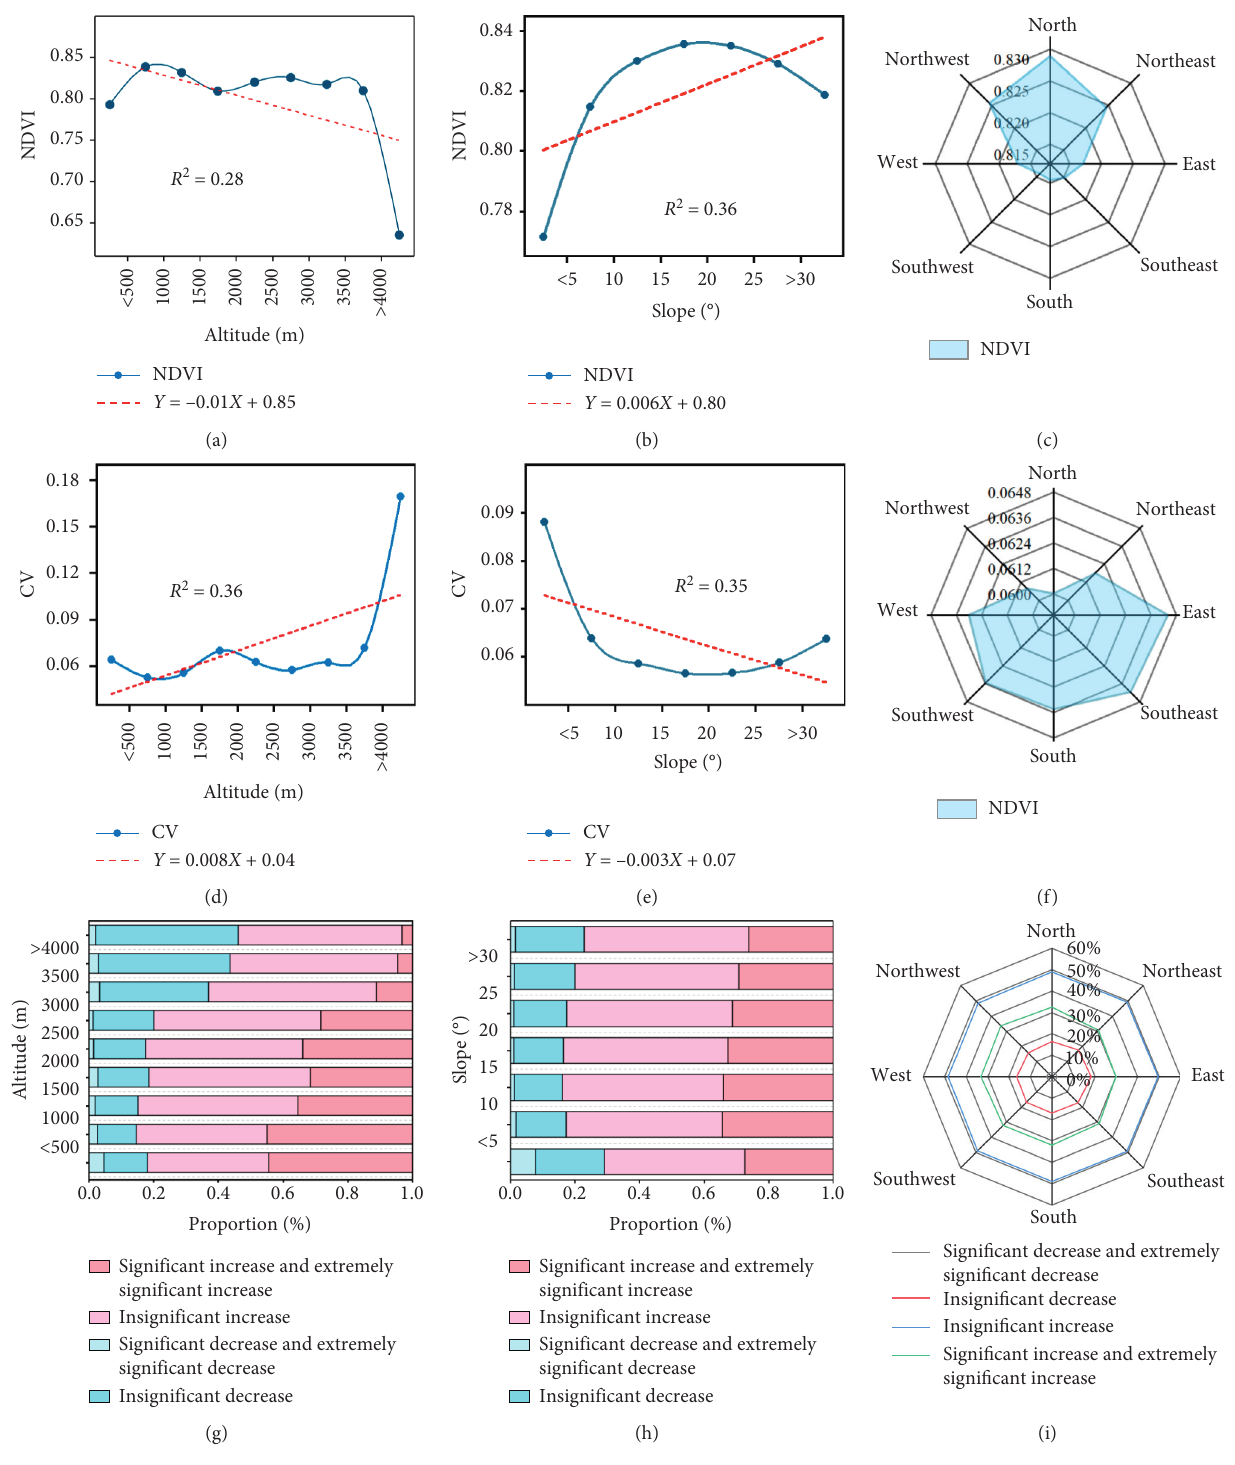
Figure 4: The relationship between different terrain factors and NDVI, CV, and NDVI trends. (a–c) Distribution and change characteristics of NDVI at different altitudes, slopes, and aspects, respectively; (d–f) distribution and change characteristics of CV at different altitudes, slopes, and aspects, respectively; (g–i) distribution and change characteristics of NDVI trends at different altitudes, slopes, and aspects,